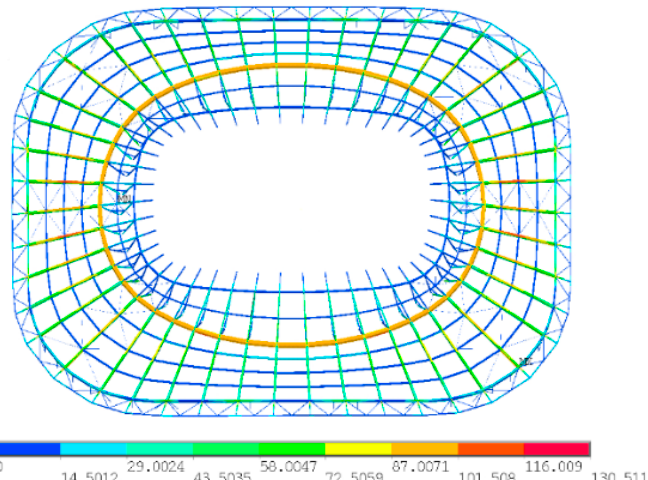
Figure 10. Stress in upper rigid grid after force-finding analysis.